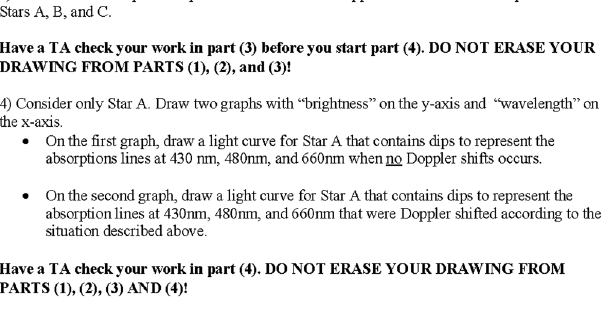
FIG. 7. SRT on Doppler